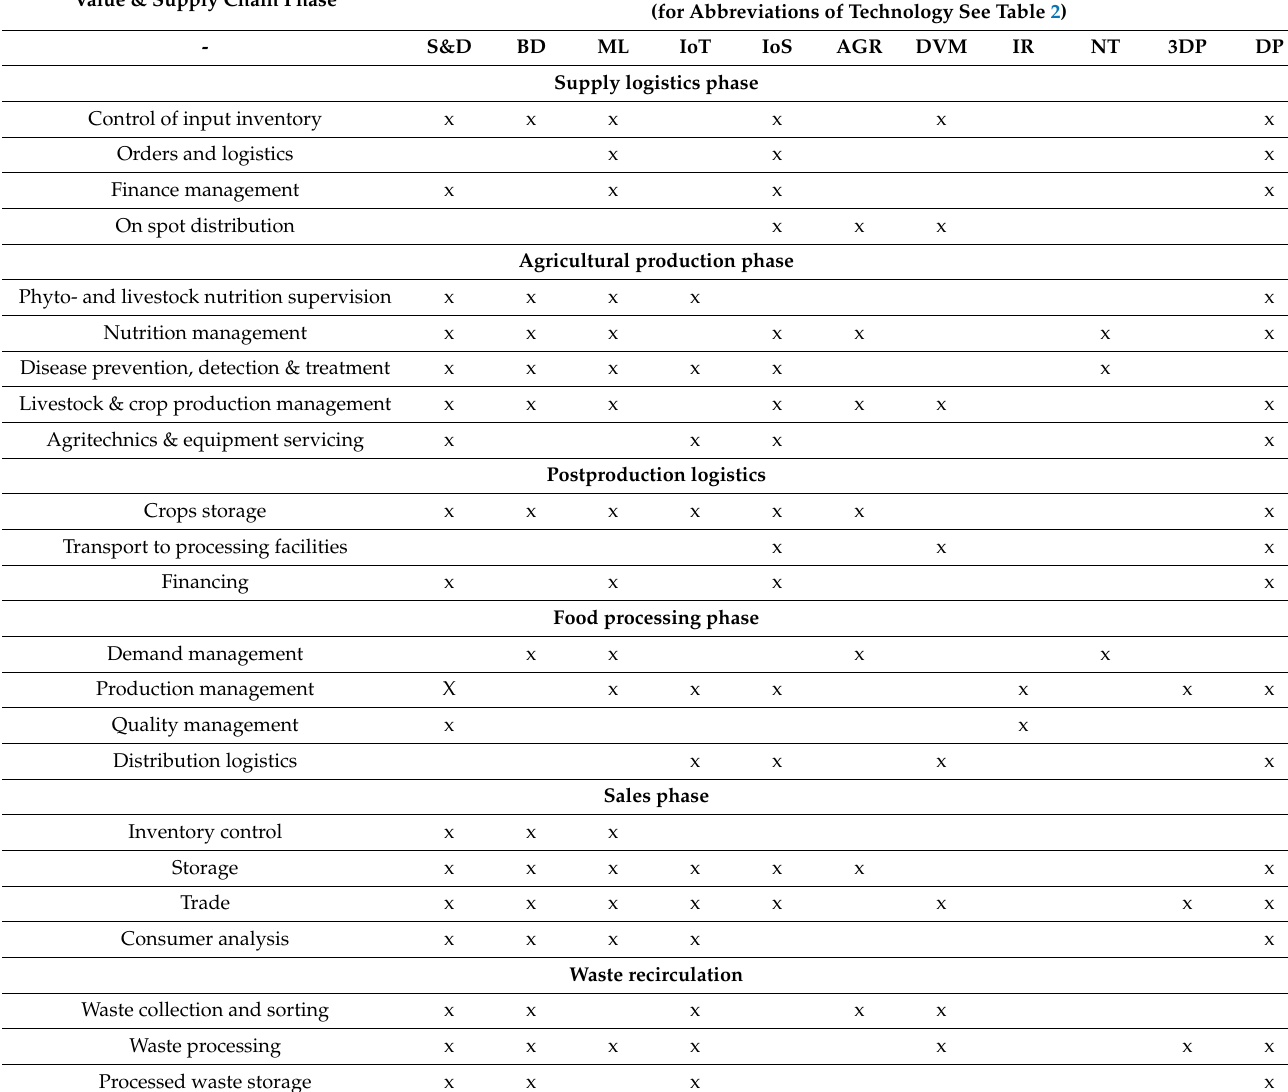
AI Components Embedded (for Abbreviations of Technology See Table